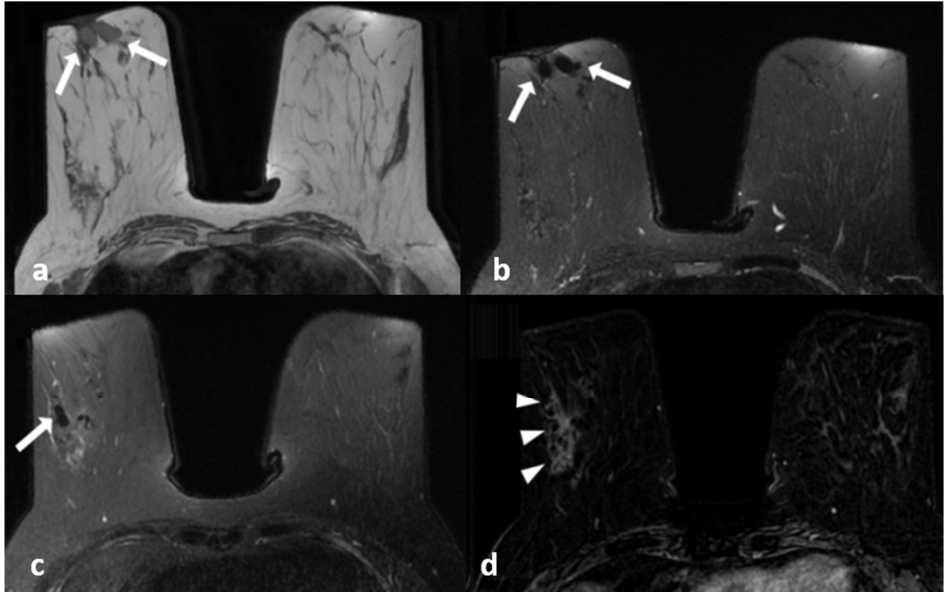
Table 2. DWI fi ndings. Figure 3. A 45-year-old woman with histopathologically proven idiopathic granulomatous mastitis involving the right breast. ( a ) Precontrast T1-weighted fast spin echo axial MR image of the patient shows dilated ducts with a high signal intensity in retroareolar region (arrows). ( b ) Axial fat-saturated T2-weighted image corresponding to ( a ), which reveals that the dilated duct has a signal loss in accordance with the fat contained (arrows). ( c ) Contrast-enhanced subtracted image demonstrates a non-mass enhancement with a clustered ring pattern in the upper outer quadrant of the right breast (arrowhead). ( d ) T2-weighted fat-saturated image corresponding to ( c ) also demonstrates the dilated ducts containing fat intensity within the enhanced area (arrow). Table 1. Non-enhanced findings of MRI for IGM and breast cancer